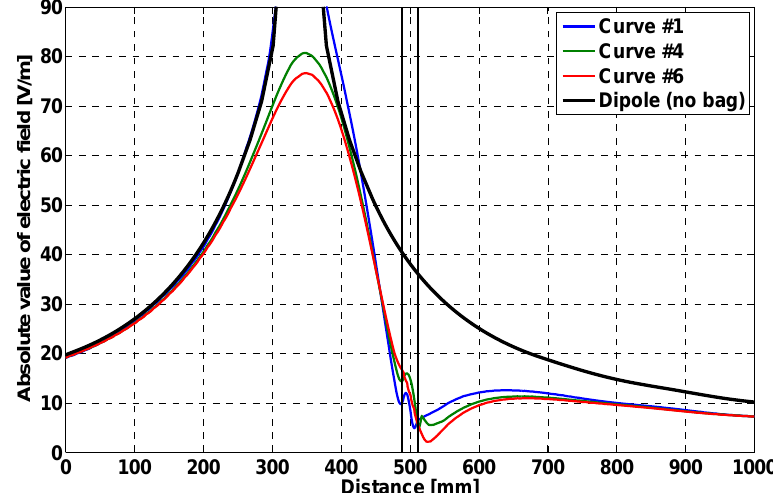
Figure 6. Field due to a dipole located at 15 cm from the bag side. The curve number refers to the segments in Figure 2. The curve labeled “Dipole (no bag)” shows, for comparison, the free ‐ space dipole field.